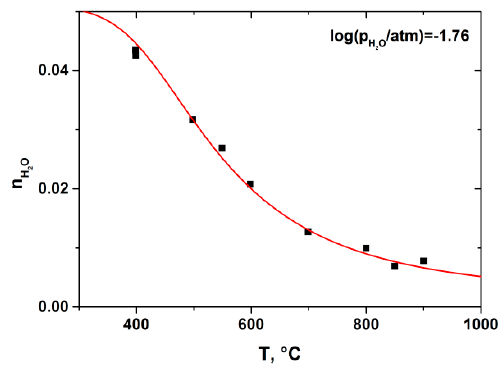
Figure A1. Water uptake of BZY10 vs. T at log( p H 2 O/atm) = − 1.76. Points-experimental data, line-result of the fit of Equation (A3).